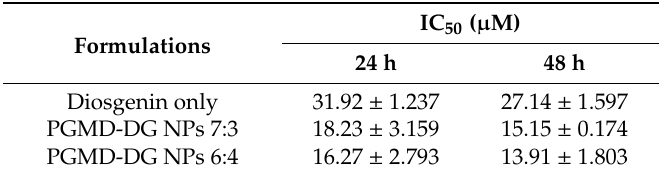
Figure 9. Illustrates the % cell viability of diosgenin only, PGMD-DG 7:3 and PGMD-DG 6:4 NPs in A549 cancer cells at different time points ( A ) 24 h, ( B ) 48 h, and ( C ) represents IC 50 values for 24 h and 48 h in A549 cancer cells. *, **, ***, **** indicates p < 0.05, 0.01, 0.001, 0.0001, respectively. Table 5. Illustrates the IC 50 value of free diosgenin and nano-formulations after 24 h and 48 h treatment in A549